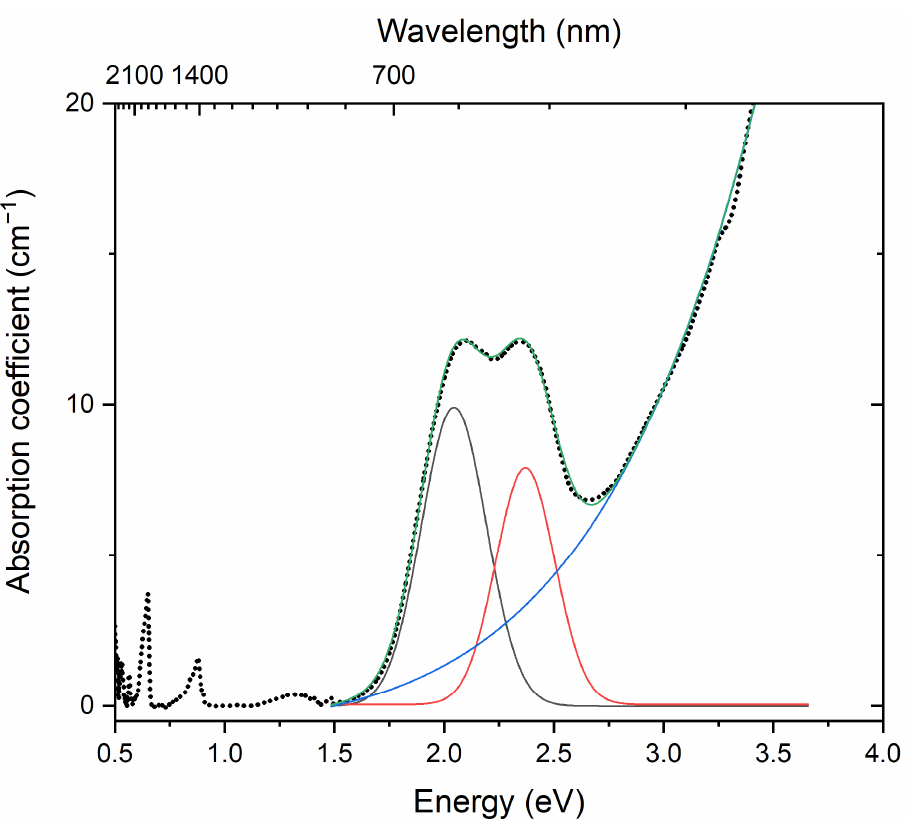
Figure 4. Absorption spectrum of haüyne (Sample 1, dotted curve). The black and red solid lines show the deconvolution of the doublet in the region of 2.0–2.5 eV into two peaks, and the total decomposition curve is shown with green color.